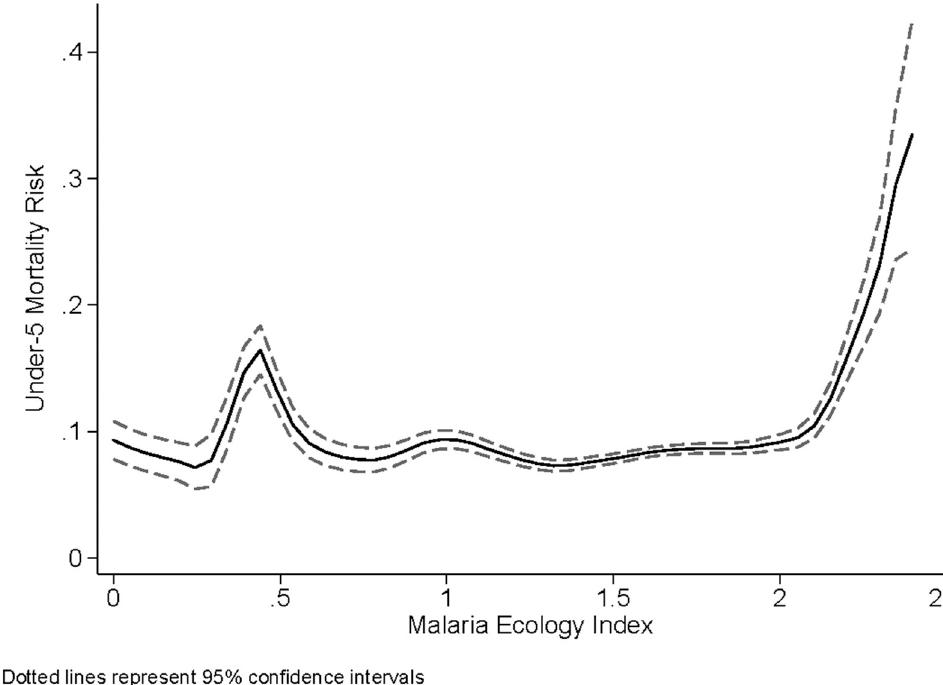
Fig 3. Average mortality risk over the range of average